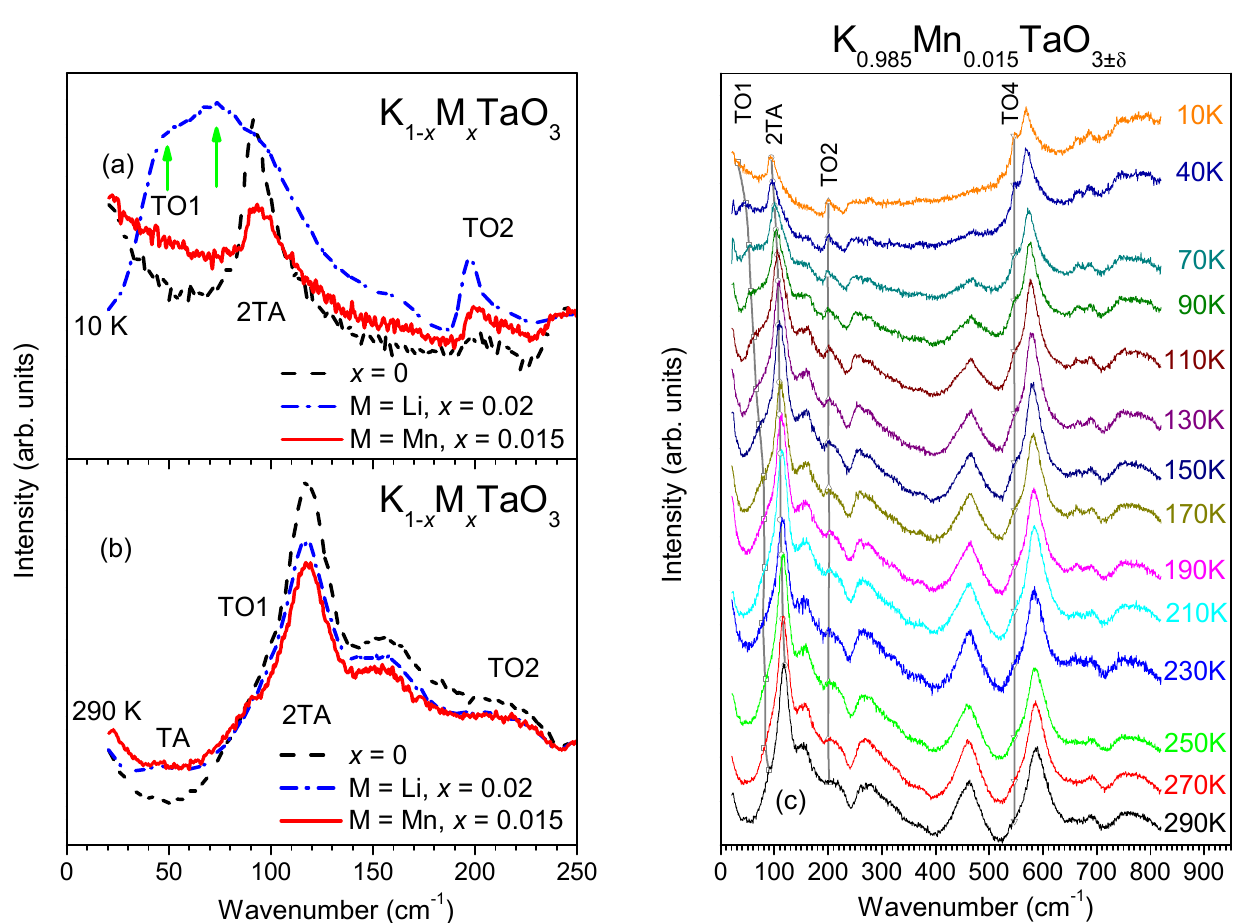
Figure 4. ( a , b ) Lower-wavenumber portions of Raman spectra for K 0.985 Mn 0.015 TaO 3 ± δ ceramics (solid lines) at 10 K ( a ) and 290 K ( b ) compared to those of ceramic KTaO 3 (dash lines) and K 0.98 Li 0.02 TaO 3 (dash dot lines) recorded at the same temperatures. ( c ) Raman spectra of the K 0.985 Mn 0.015 TaO 3 ± δ ceramics over a broad wavenumber range recoded between 10 K and 290 K ( c ).